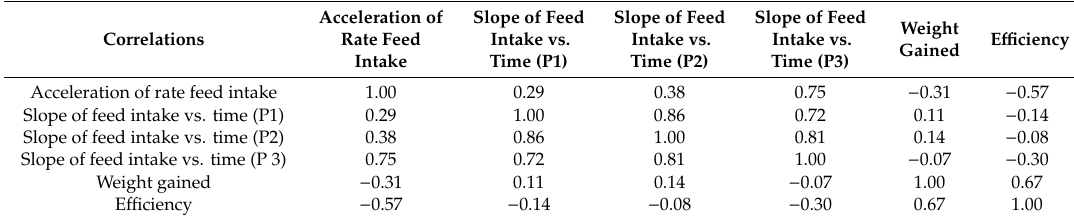
Table 5. Correlation between the slopes of the feed intake vs. time adjustment lines, acceleration of the rate of feed intake, weight gained, and feed e ffi